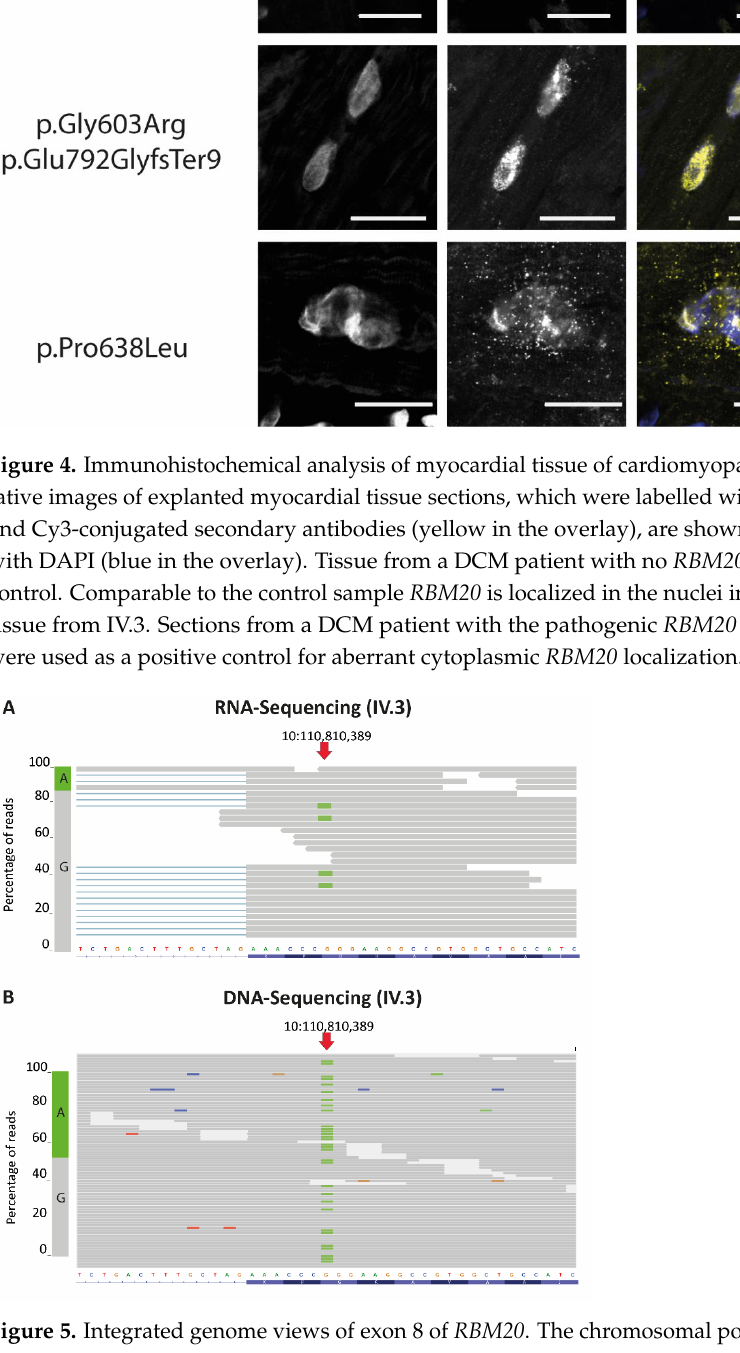
Figure 5. Integrated genome views of exon 8 of RBM20 . The chromosomal position corresponding to RBM20 c.1807 is marked with an arrow. Shown are the aligned reads obtained by RNA-sequencing ( A ) or DNA-sequencing ( B ) in the respective chromosomal region of index patient IV.3 ( RBM20 p.Gly603Arg+p.Glu792fsTer9 and TTN p.Glu8271Gln+ p.Lys23669Ter). At chromosomal position 10:110,810,389 approximately 15% of the RNA reads ( A , bar on the left) represent the mutant form, whereas 46% of the reads ( B , bar on the left) at chromosomal position 10:110,810,389 represent the mutant DNA form.